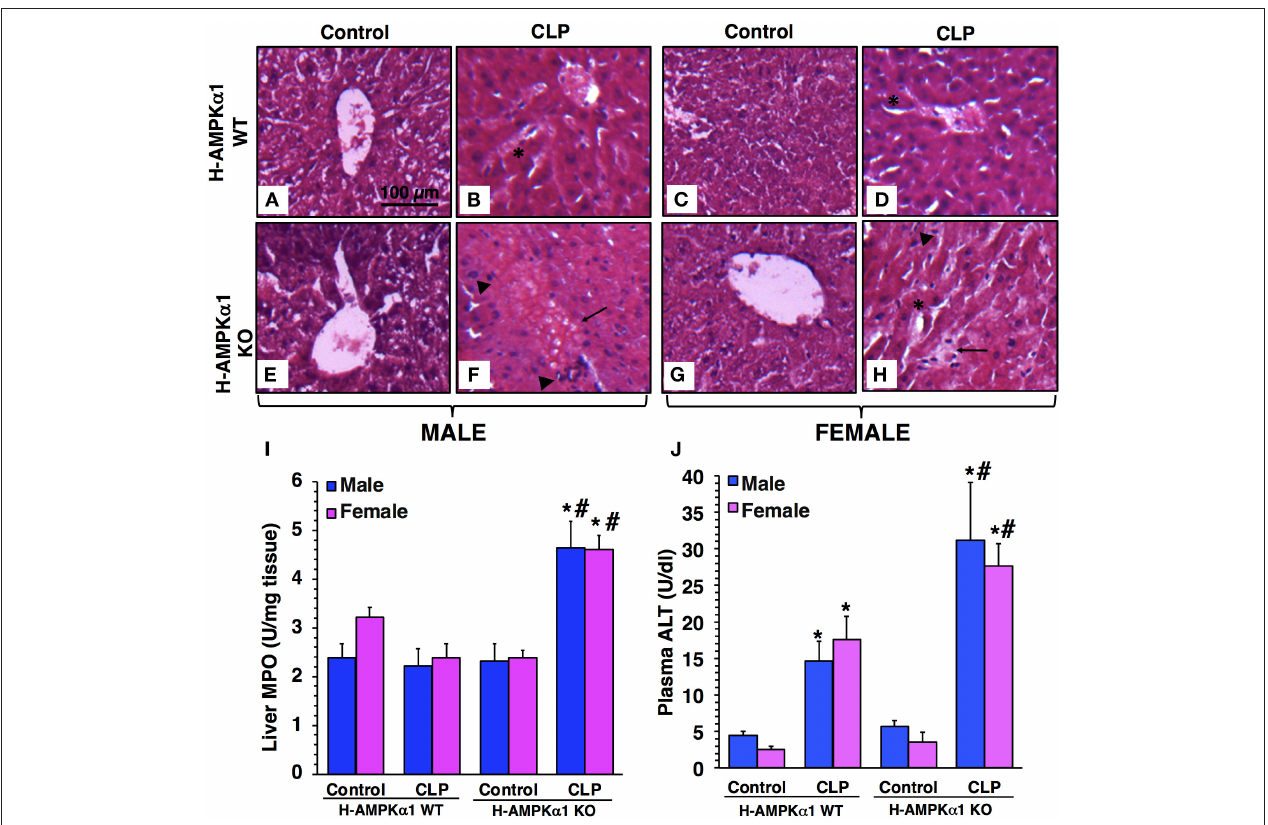
FIGURE 1 | Representative histology photomicrographs of liver sections of hepatocyte-specific (H-AMPK α 1) wild-type (WT) and knock-out (KO) mice at basal control condition and at 18h after cecal ligation and puncture (CLP). Normal liver architecture in control male WT (A) and male KO (E) , and in control female WT (C) and female KO (G) mice. Liver damage in male (B) and female (D) H-AMPK α 1 WT mice with modest areas of sinusoid congestion (asterisks). Liver damage in male (F) and female (H) H-AMPK α 1 KO mice with necrosis (arrows) and infiltration of inflammatory cells (arrowheads). Magnification × 100; scale bar = 100 µ m. A similar pattern was seen in n = 4–8 different tissue sections in each experimental group. Liver myeloperoxidase (MPO) activity (I) , plasma ALT levels (J) in male and female H-AMPK α 1 WT and KO mice at 18h after CLP. Data represents the mean ± SEM of 4–8 mice for each group. * P < 0.05 vs. sex-matched control mice; # P < 0.05 vs. sex-matched WT